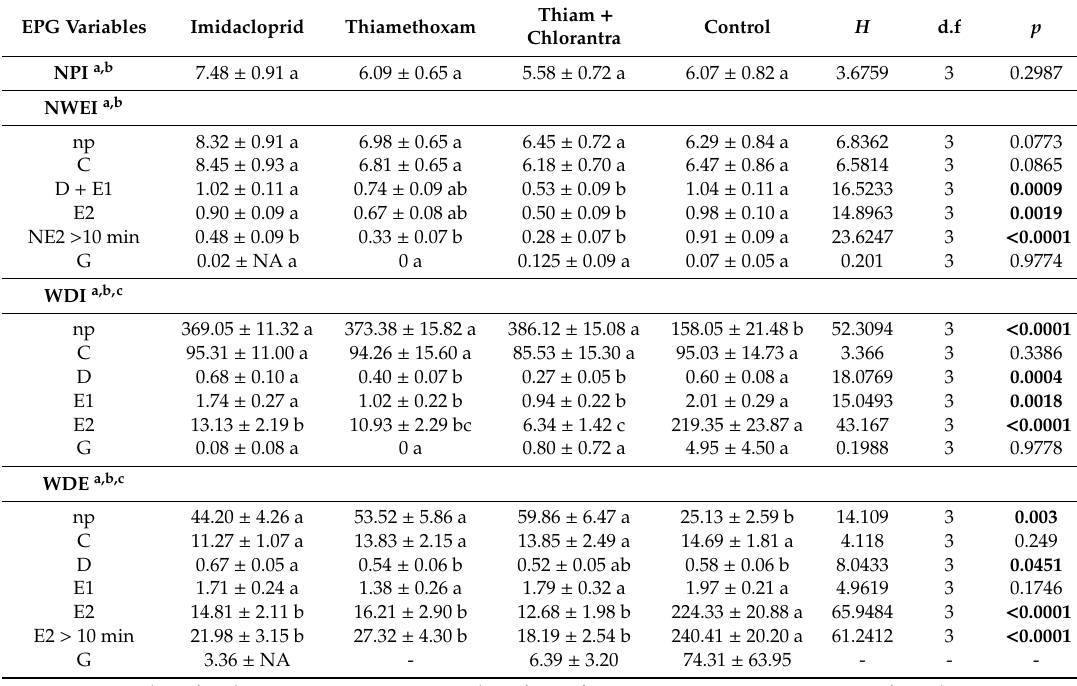
Table 2. Means ( ± standard error) of EPG variables for 8 hours monitoring of Diaphorina citri on Citrus sinensis nursery tree treated by drench with systemic insecticides (20 days after